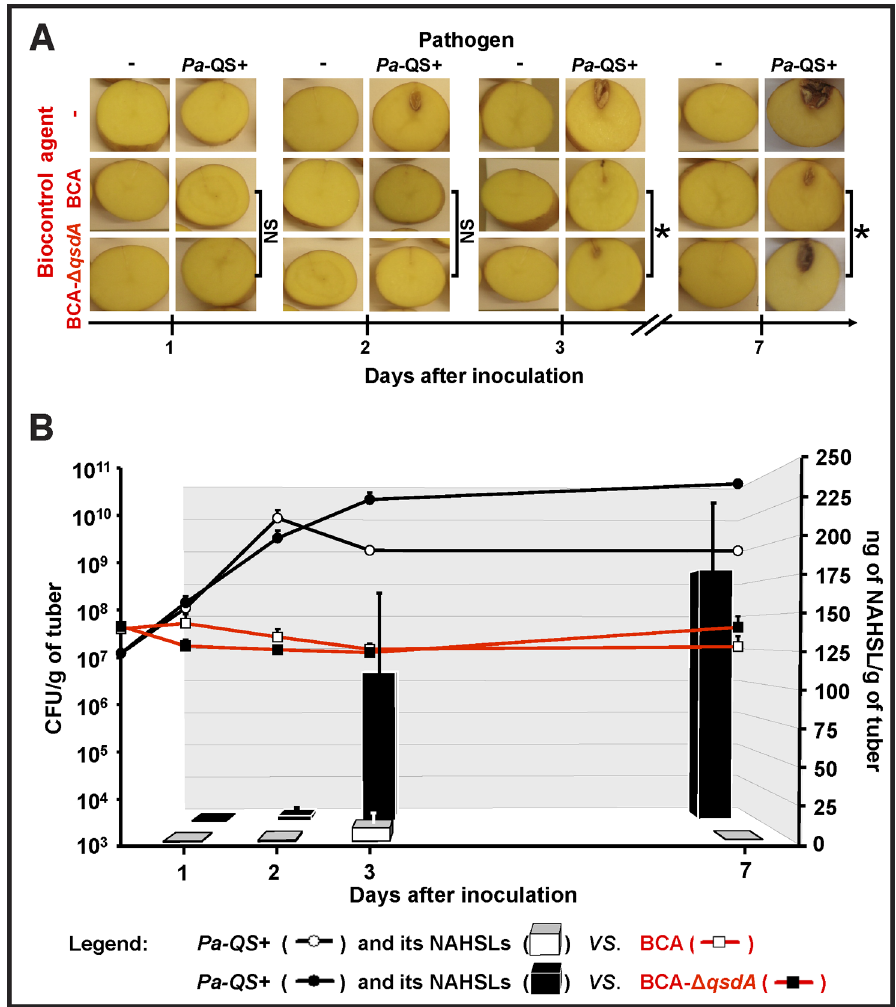
Figure 2. NAHSL-breakdown and biocontrol activity of the R.erythropolisqsdA deletion mutant in potato tubers. (A) The R. erythropolis R138 wild-type (BCA) and the R. erythropolis R138 D qsdA (BCA- D qsdA ) strains were compared for biocontrol activity against P. atrosepticum 6276 ( Pa - QS + ) 1, 2, 3 and 7 days after inoculation of potato tubers. For the controls, one or both strains were replaced in the inoculum with a 0.9% NaCl solution. Significant differences (Mann and Whitney test; a =0.05) in maceration symptoms between infected tubers inoculated with the BCA or the BCA- D qsdA are indicated with an asterisk. (B) Population dynamics of P. atrosepticum and R. erythropolis bacteria (CFU/g fresh weight of potato tubers; black and red lines respectively), and NAHSL concentrations (ng/g of potato tubers; black and white bars) were determined for each condition in potato tubers. For lines and bars, each value is the mean of three replicates with the standard deviation indicated. NS, non-significant; NAHSL, N - acyl homoserine